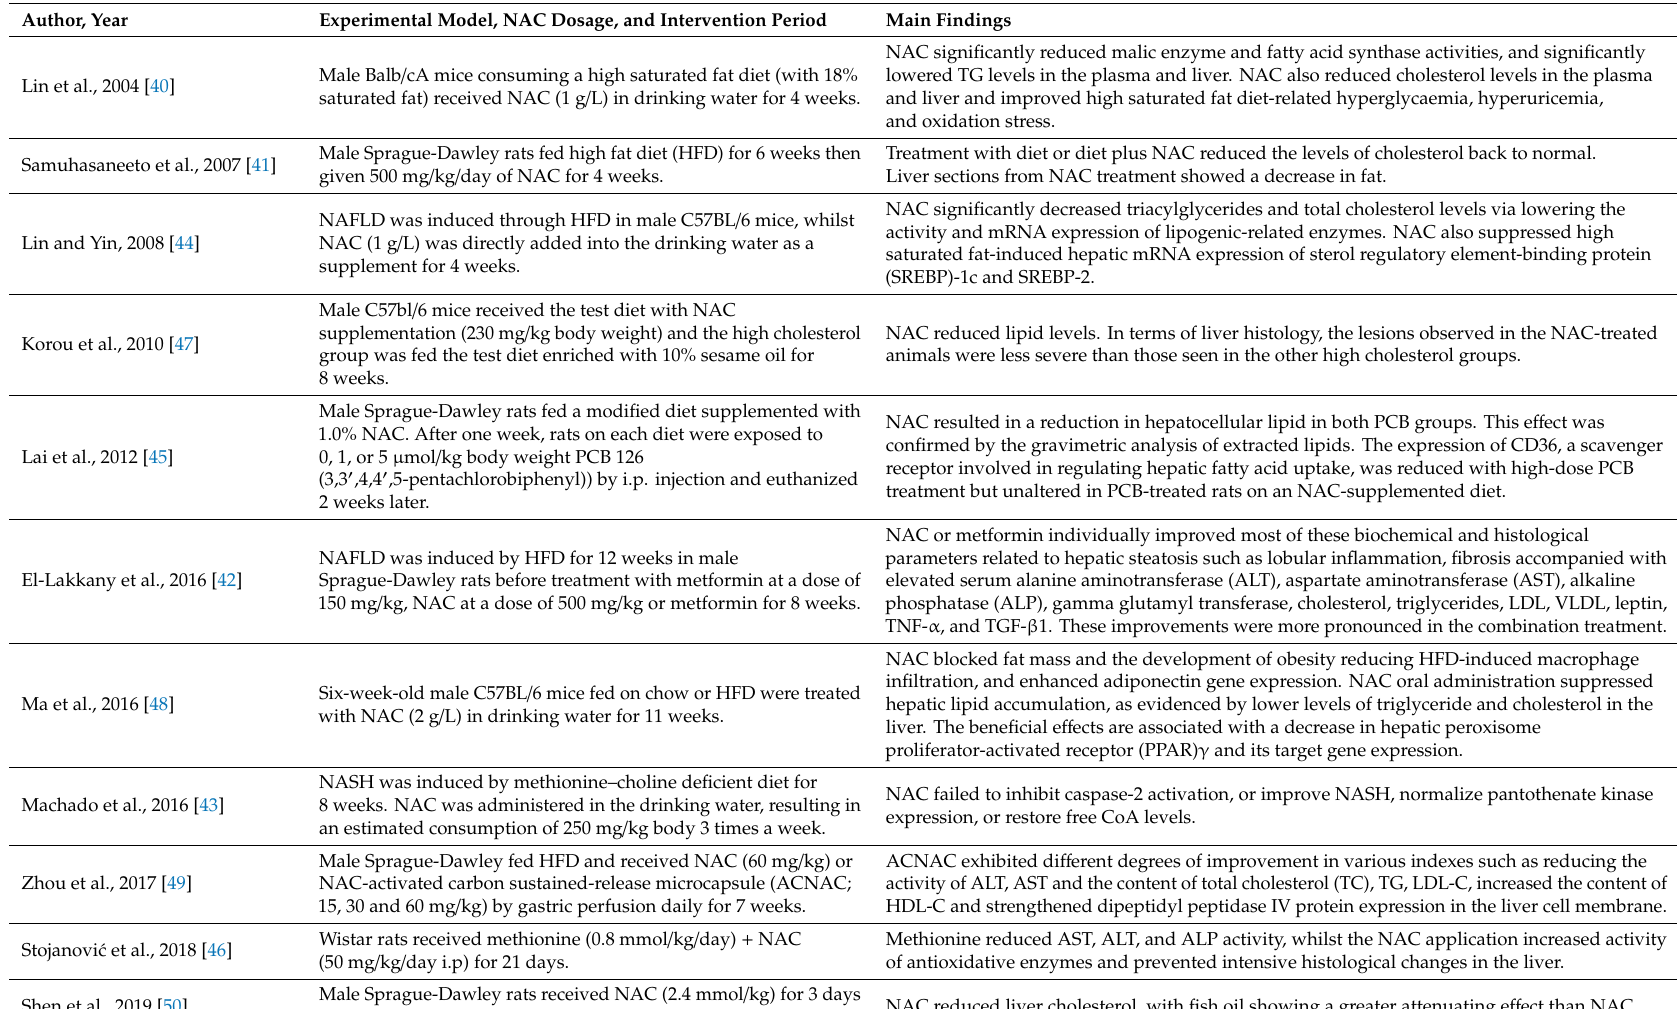
Table 1. An overview of studies on N-acetyl cysteine (NAC) and its impact on hepatic lipid accumulation in preclinical models of